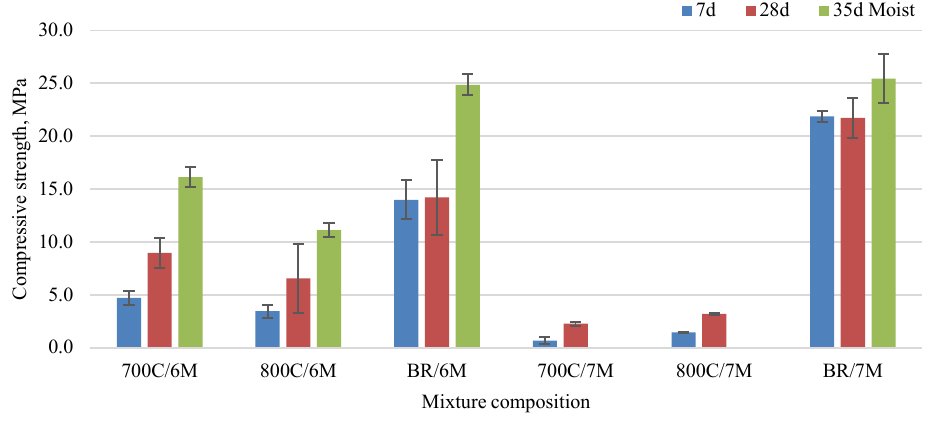
Fig. 9. Mechanical properties of red clay based